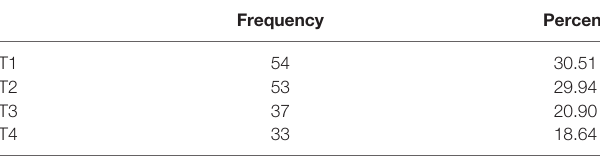
TABLE 4 | pT-stage for primary diagnosis in the whole patient cohort.